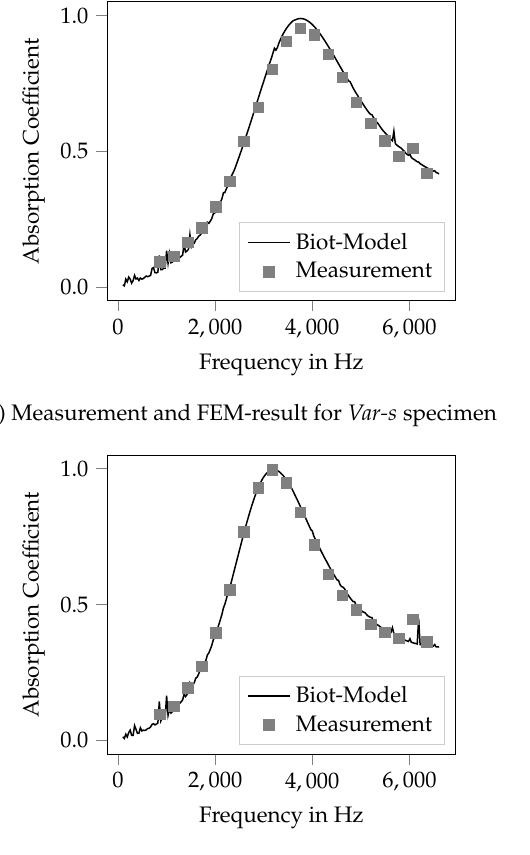
( c ) Measurement and FEM-result for Var-d specimen ( d ) Measurement and FEM-result for Var- ϕ specimen Figure A2. Further results for measured and computed absorption characteristics after inverse parameter